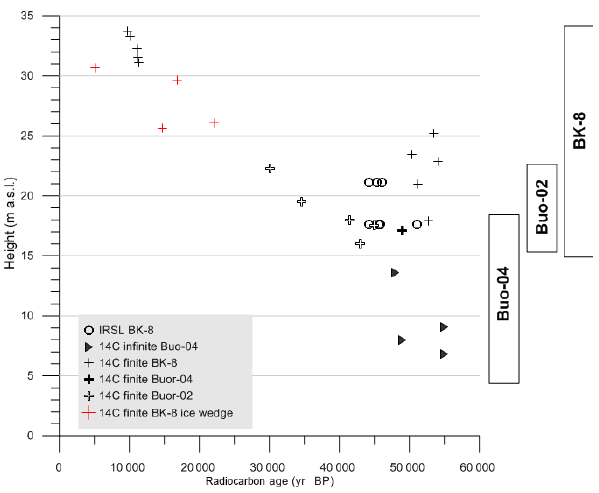
Figure 13. Compilation of geochronological results of Yedoma IC obtained in two profiles (Buo-02, Buo-04) and one drill core (BK-8) at the western coast of Buor Khaya